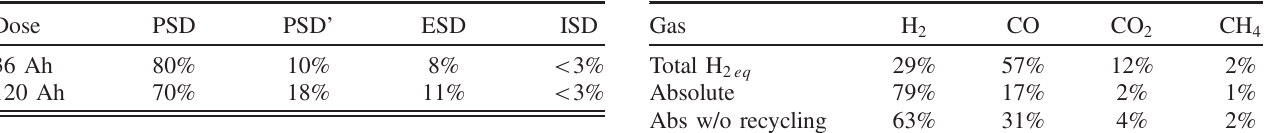
TABLE X. Gas load ratios of the beam vacuum induced effects for two different arbitrary doses. Dose PSD PSD ’ ESD ISD